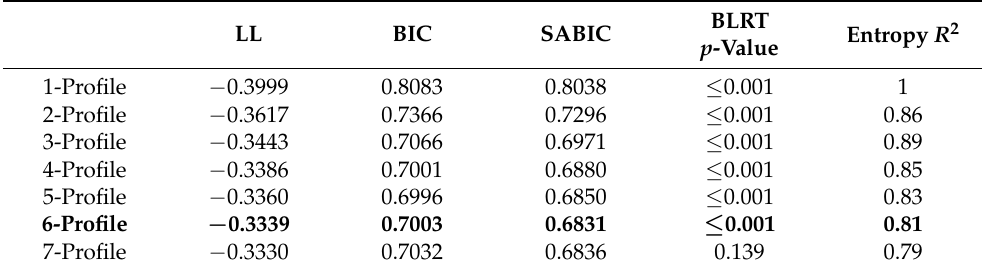
Table 4. Model fit indices for latent profile